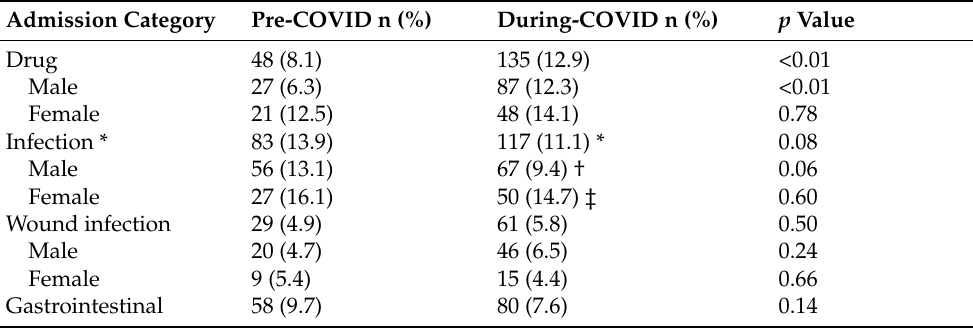
Table A3. Proportional changes in ED admissions among non-Indigenous patients with SUD before and during the COVID-19 pandemic (based on the number of admissions, not the number of patients; some patients had more than one